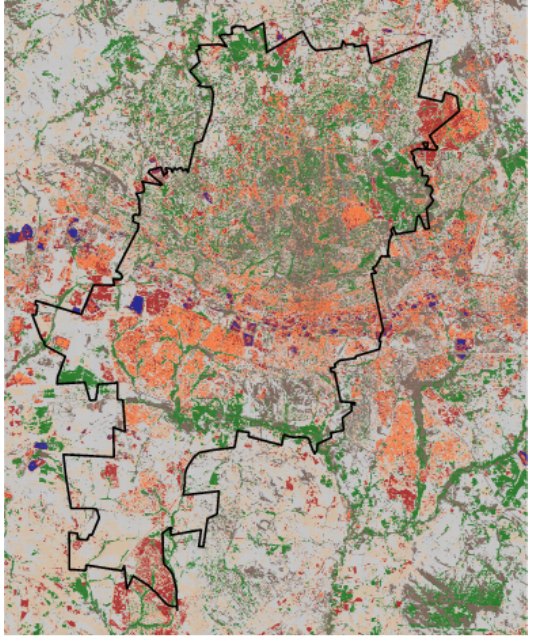
Figure 3: Result of k-means classification on Landsat 7 image (15 March 2003) of the study area.